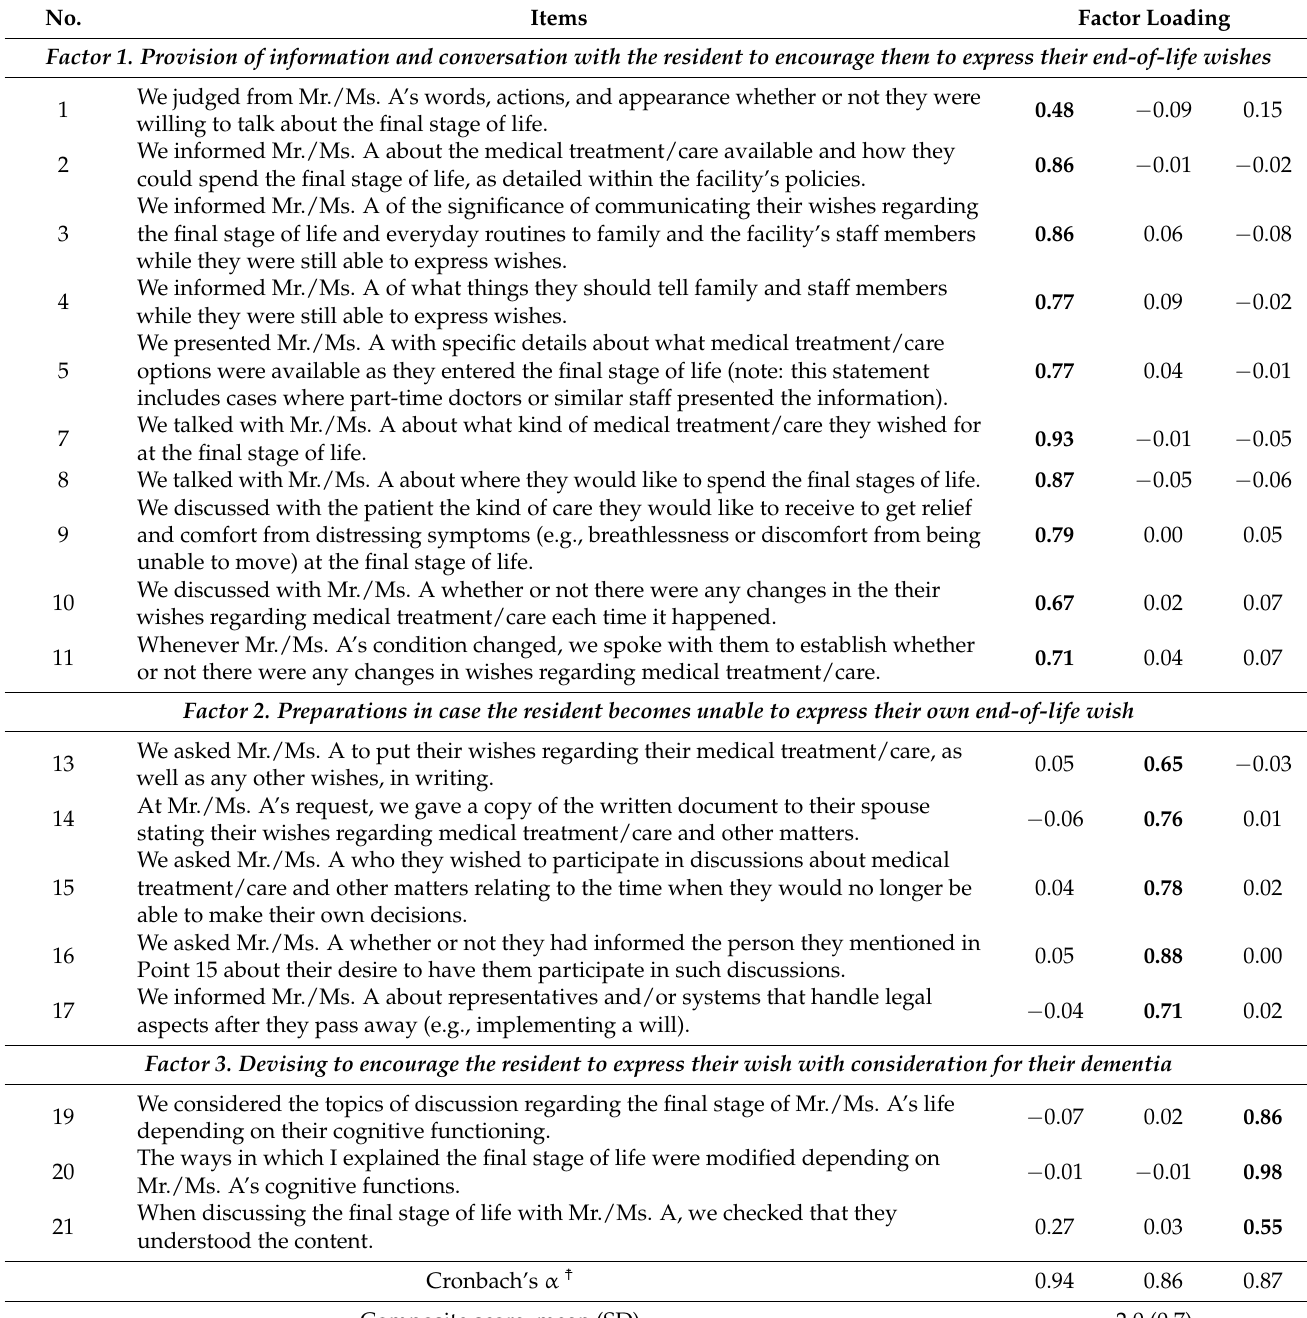
Table 4. Final exploratory factor analysis, Cronbach’s α , and descriptive statistics of the ACP-PI ( N = 228).